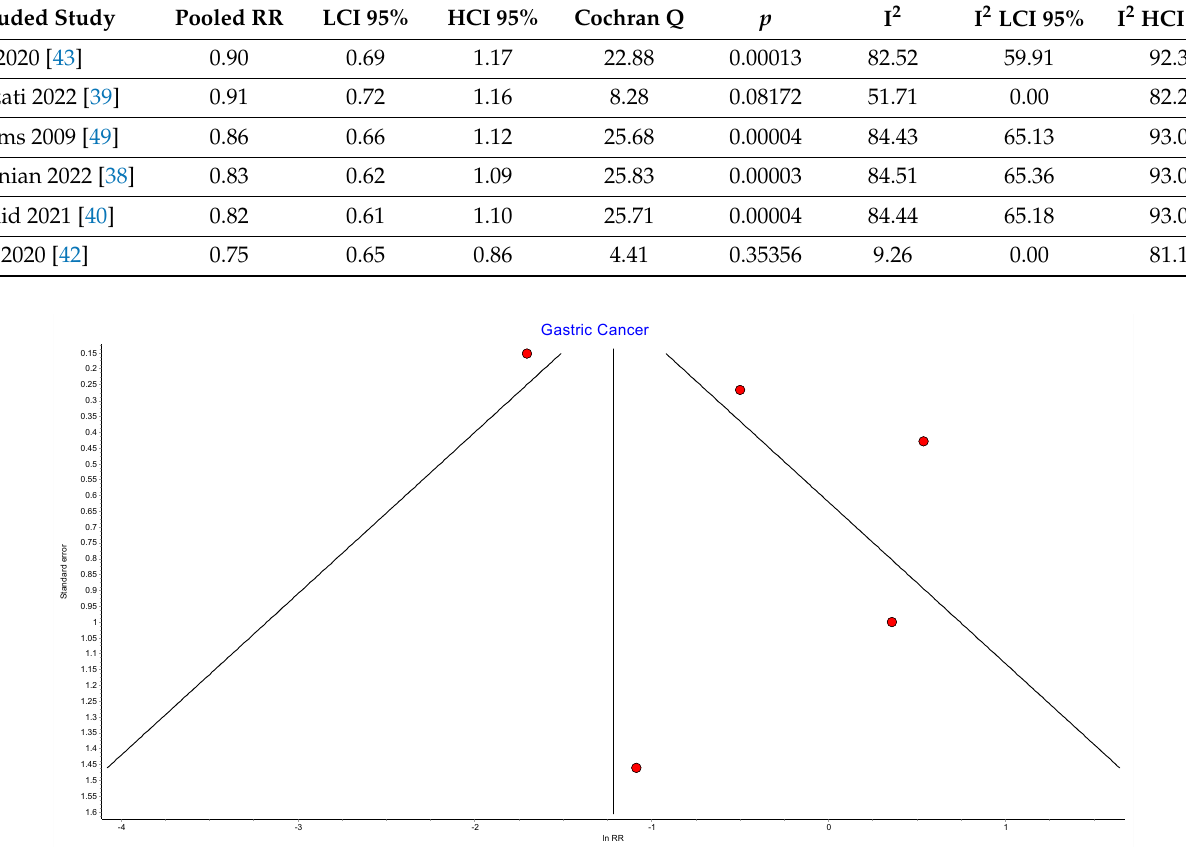
Table A18. Thyroid cancer random effects model sensitivity analysis.